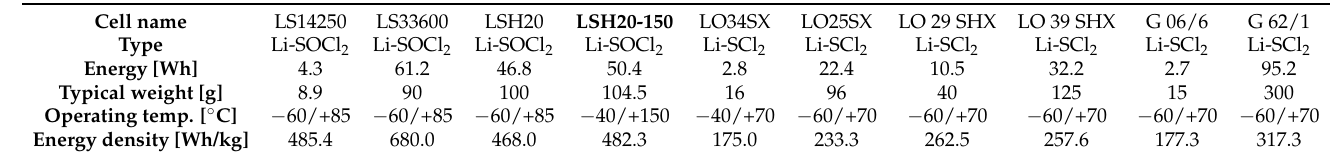
Table 3. Characteristics of investigated non-rechargeable battery